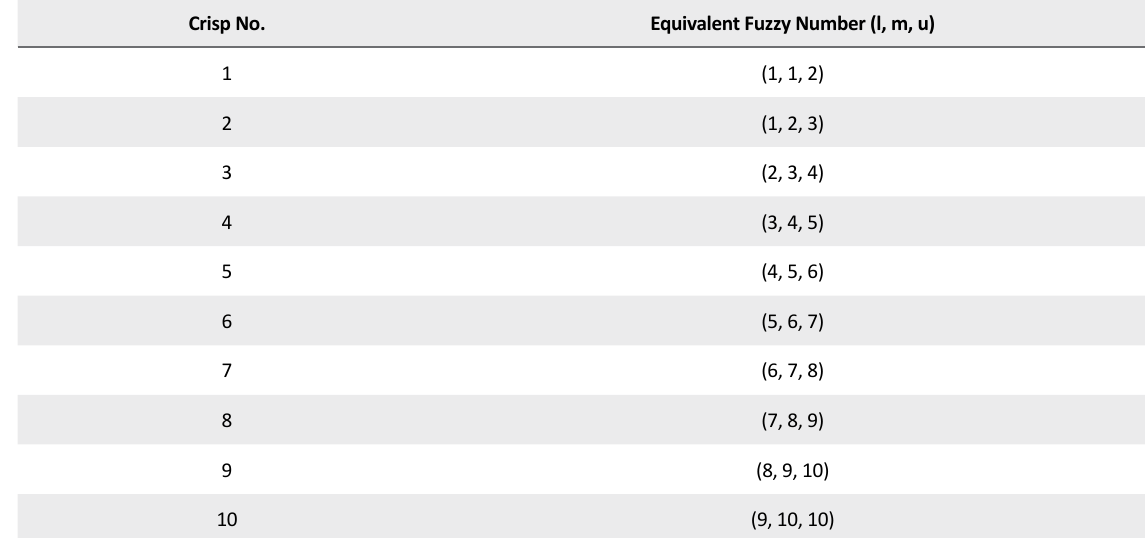
Table 4. Equivalent fuzzy numbers Crisp No.